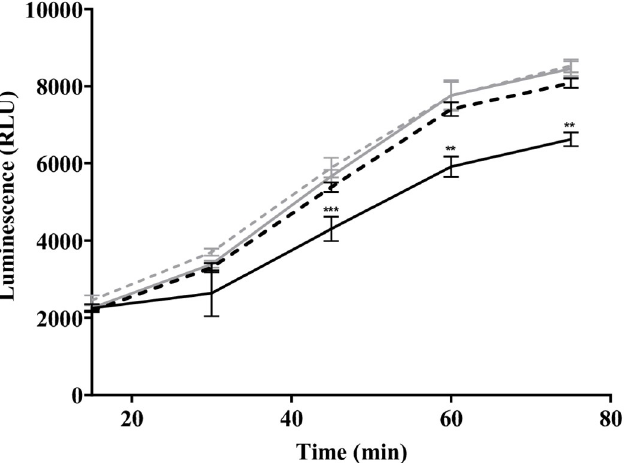
Fig 4. Arginine supplementation enhances H . influenzae ATP production. Relative ATP production measured by luminescence (relative light units, RLU), of H . influenzae without supplementation of arginine (black), and with supplementation of 2 g/L (black dotted line), 4 g/L arginine (grey filled line) and 6 g/L arginine (grey dotted line). Luminescence (ATP production) is significantly higher in all concentrations of arginine, compared to no arginine supplementation. Significant differences were determined with a student t-test ( ��� p � 0.001, �� p � 0.01).